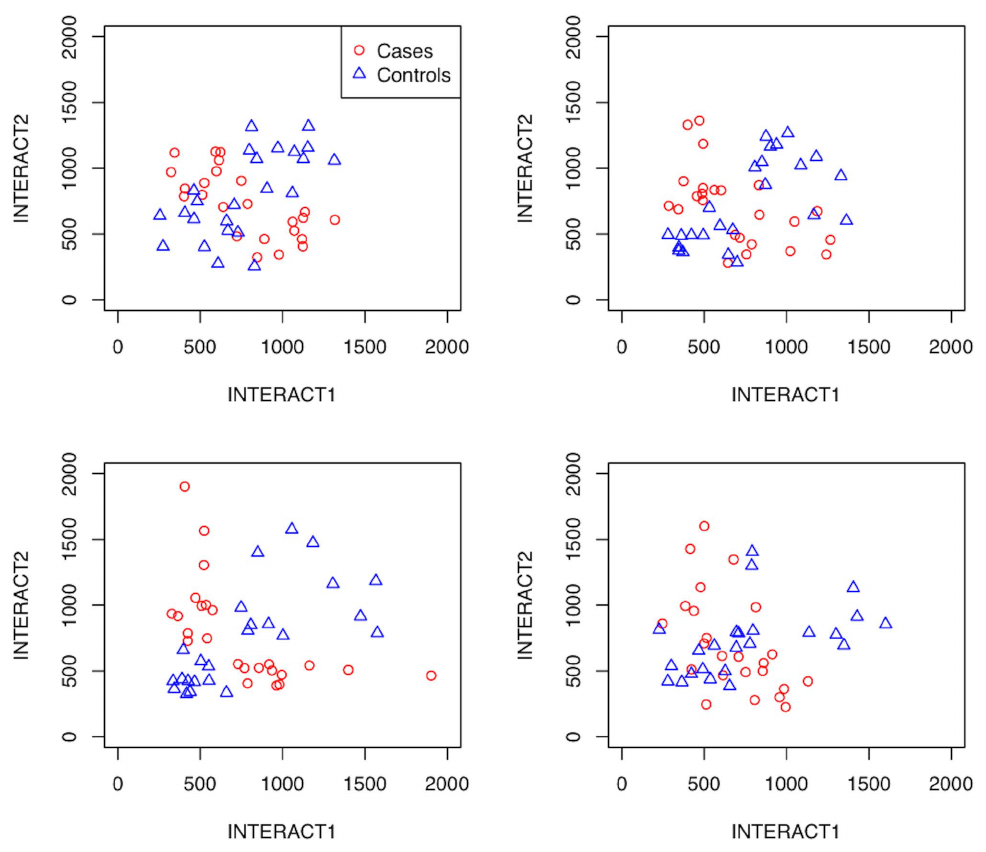
Figure 4. Example scatter plots of simulated data for two interacting transcripts. Each scatter plot is a replicate of the same XOR simulated model. Cases and controls are labeled in the 2-dimensional space of the two interacting transcripts (labeled INTERACT1 and INTERACT2). The simulated data includes approximately 16,000 null genes, but only the two interacting genes are shown. The XOR model is designed so that neither interacting gene by itself has a statistically significant differential expression between cases and controls (no main effect).